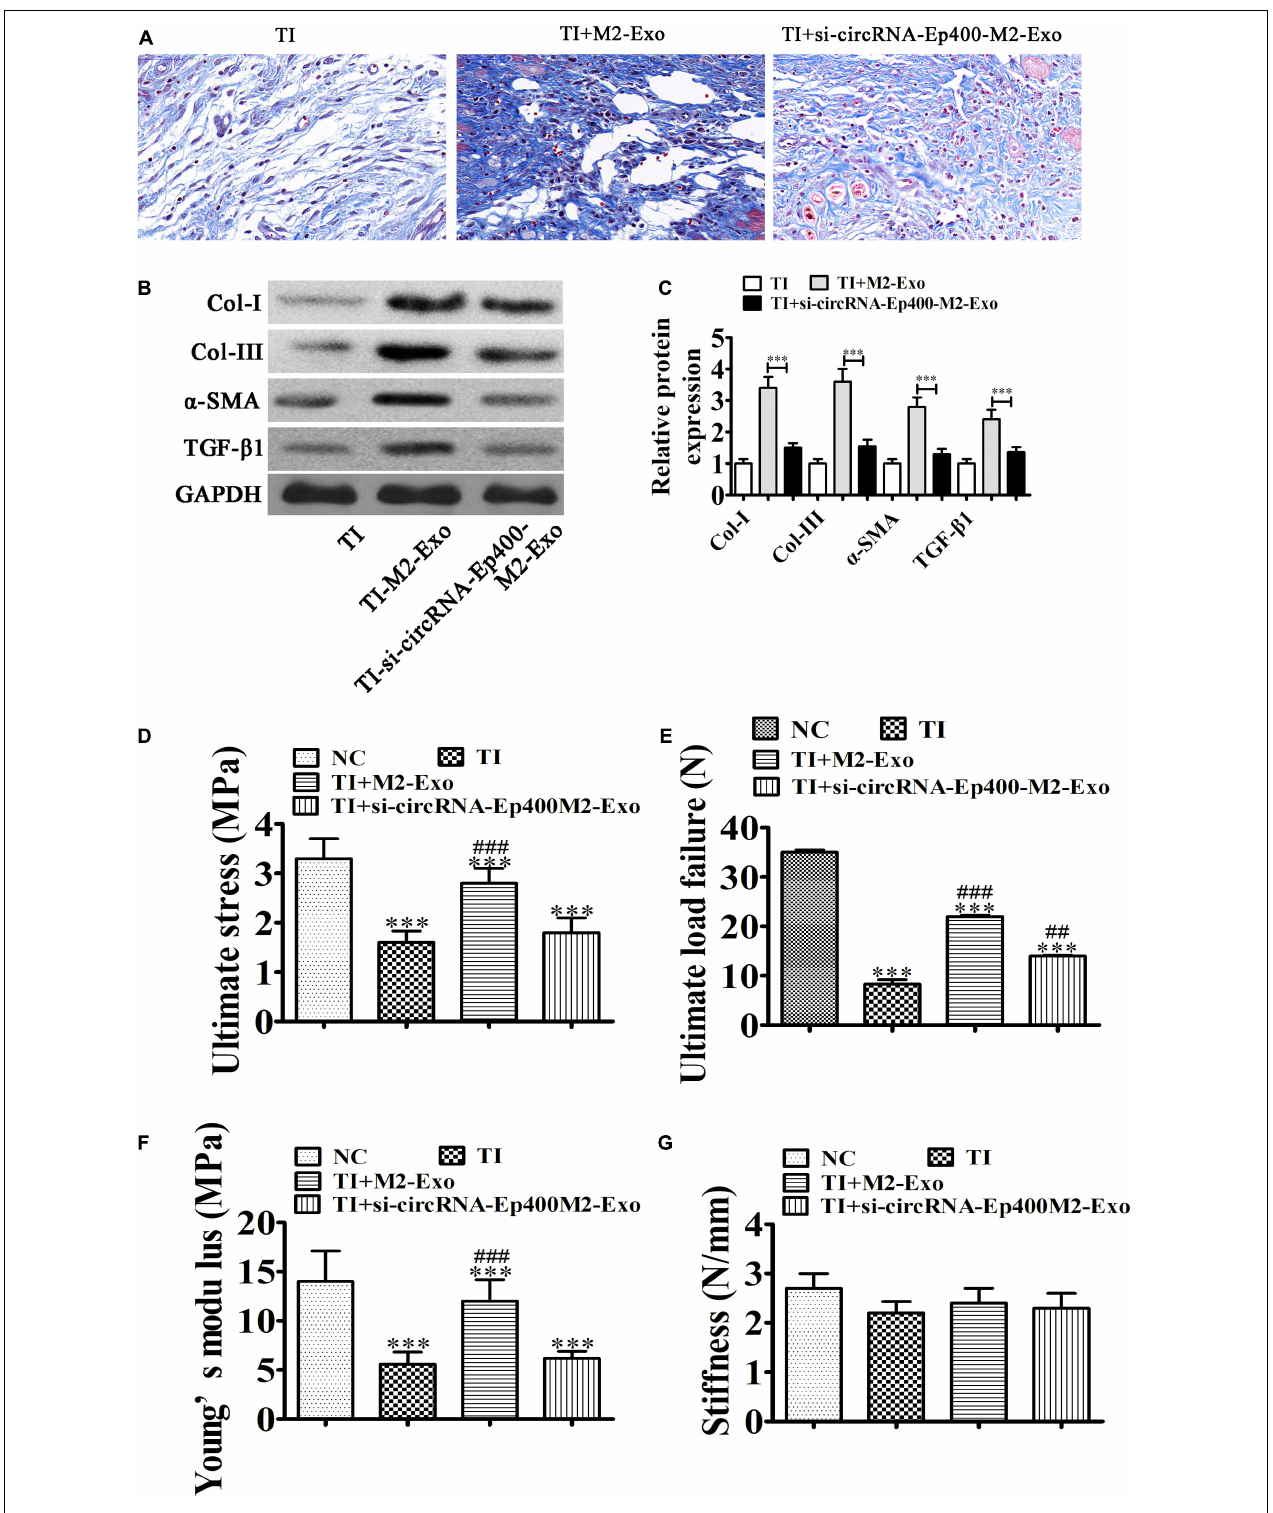
FIGURE 3 | M2 macrophage-derived circRNA-Ep400-containing exosomes function in promoting peritendinous fibrosis after tendon injury. (A) Masson’s trichrome staining showing the fibrosis of tendon tissue. (B,C) Western blot analysis and quantification of the Col I, Col III, and α -SMA, as well as TGF- β 1 expression levels. The results are expressed as the mean ± SD, ∗∗∗ P < 0.001. (D–G) The tensile strengths of tendons after impairment were measured, including ultimate stress (D) , ultimate load failure (E) , Young’s modulus (F) , and stiffness (G) . The results are expressed as the mean ± SD. ∗∗∗ P < 0.001 vs. NC. ## P < 0.01, ### P < 0.001 vs. TI.